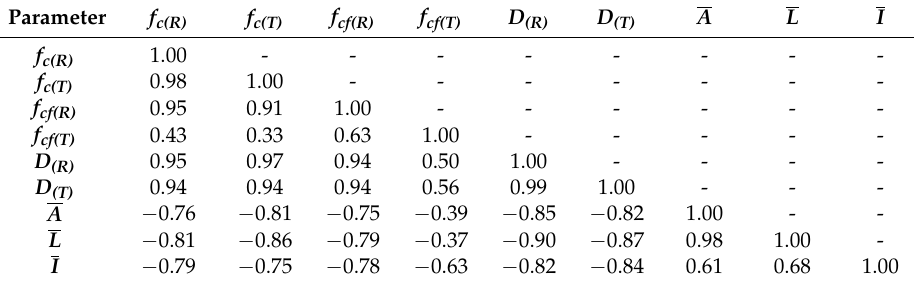
Table 2. Correlation matrix of the parameters examined of the cement